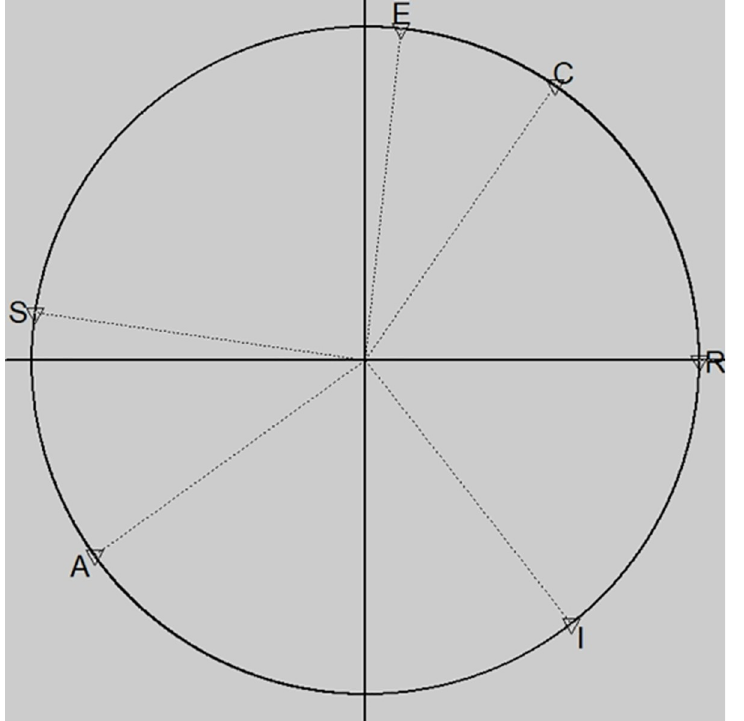
Fig 2. Data circumplex goodness of fit.